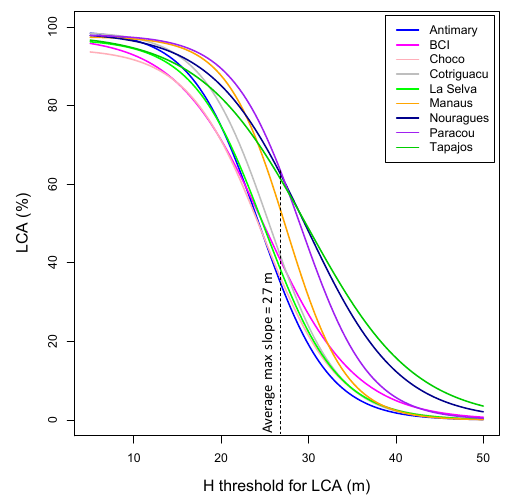
Figure 2. LCA as a function of height thresholds in the nine study sites. The steepest slopes are between 24m (Antimary) and 30m (Nouragues), with an average of 27m across sites. Steepness of slope was obtained by calculating the derivative of the sigmoid models characterizing each